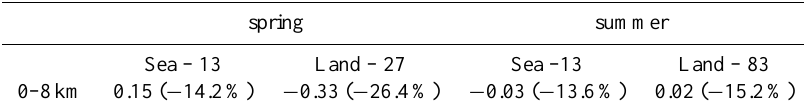
Fig. 10. Left panel: average IASI O 3 profiles (blue lines) and smoothed lidar profiles (red lines) in units of 10 12 moleculescm − 3 over sea (a) land (b) . Lidar profiles were measured above 4km. The upper horizontal dashed black line represents the mean altitude where the lidar profile ends and the climatology starts. The lower horizontal dashed black line represents the mean altitude where the a priori profile ends and the lidar profile starts. Error bars represent the variability of averaged smoothed data (standard deviation ± 1 σ) . The coloured numbers indicate the average [0–12km] columns in 10 17 moleculescm − 2 and the standard deviation. Right panel: average relative difference (RD) in % (thick blue lines for profiles and numbers below the graphs on the right are the average differences for [0–12km] columns) and ± 1 σ (thin blue lines). The number of lidar observations and IASI co-located pixels are noted at the top right of the panels. The mean ECMWF dynamical tropopause is at 9.1 and 8.8km, respectively. Table 2. Summary of correlations between retrieved IASI O 3 and smoothed in situ O 3 [0–8km] columns for the spring and the summer campaigns according to surface type. The number of observations is provided next to the surface type. The relative difference is given in parentheses.